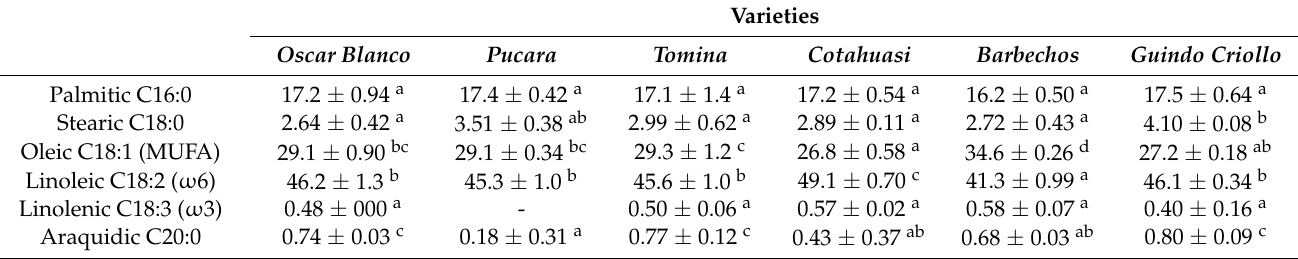
Table 3. Fatty acid composition of six Amaranthus caudatus varieties. The results are presented in relative percentage as mean ± standard deviation ( n = 3). For each compound, different superscript letters in rows indicate significant differences between the amaranth varieties (Tukey’s test, p <